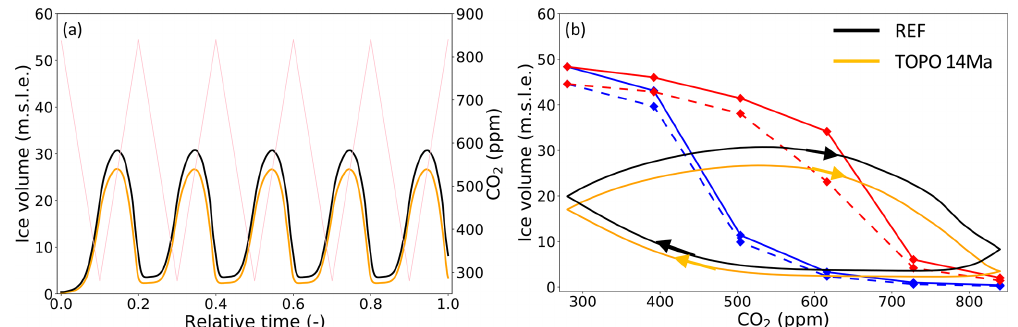
Figure 5. (a) Evolution of forcing CO 2 levels (pink) and ice volume over relative time for the transient 40kyr REF (black) and TOPO 14Ma (orange) simulations. (b) Relation between CO 2 and equilibrium ice volume (REF, solid red and blue; TOPO 14Ma, dashed red and blue) and transient ice volume (as in a ). Only the equilibrium cycle (final 40kyr) is